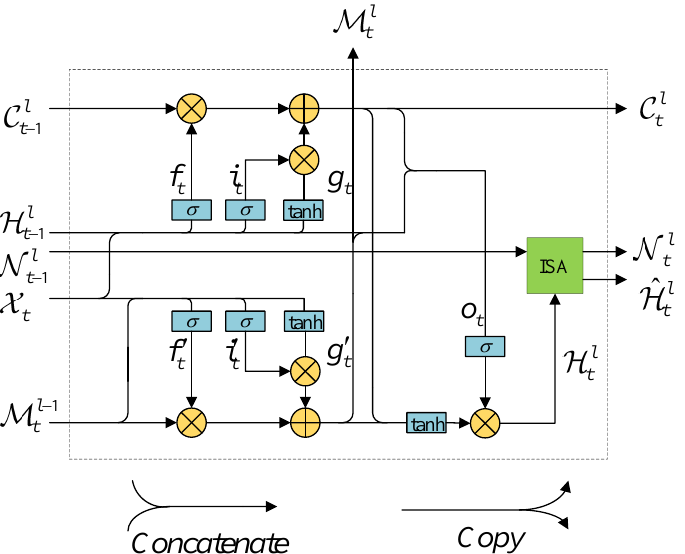
Figure 4. ( a ) The operation principle of the self-attention mechanism. The three matrices K x , Q x and V x are originated from the input X . We can extract the global key information of the input X by performing the corresponding operations on K x , Q x and V x . ( b ) The information processing flow of ISA-LSTM. The final hidden state ˆ H l and the current moment memory state N l are obtained from the previous moment’s memory state N l and the intermediate hidden state H l after being processed by the self-attention module and the corresponding gating mechanism.